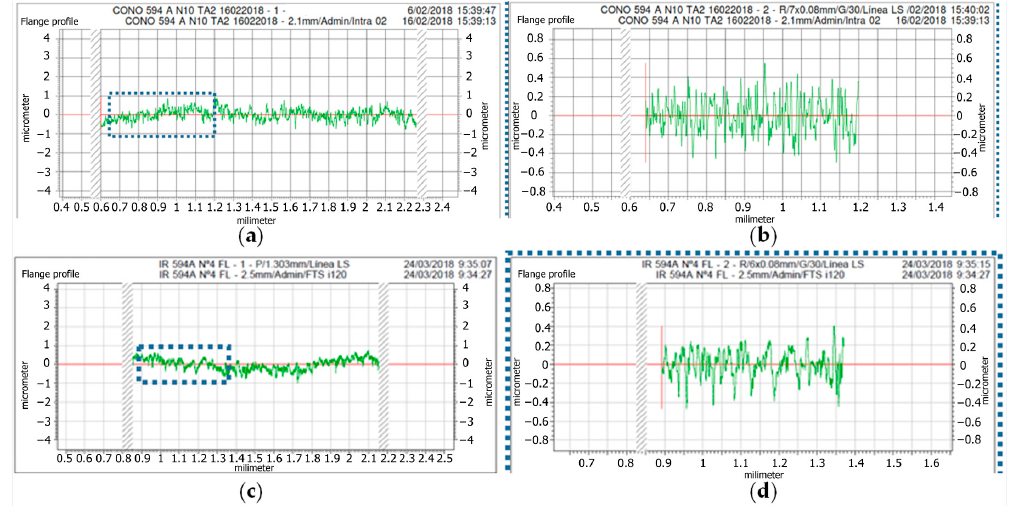
Figure 5. Flange profile for ( a ) Uncoated bearing; ( b ) uncoated bearing at the selected area in ( a ), ( c ) coated bearing; and ( d ) coated bearing at the selected area in ( c ).